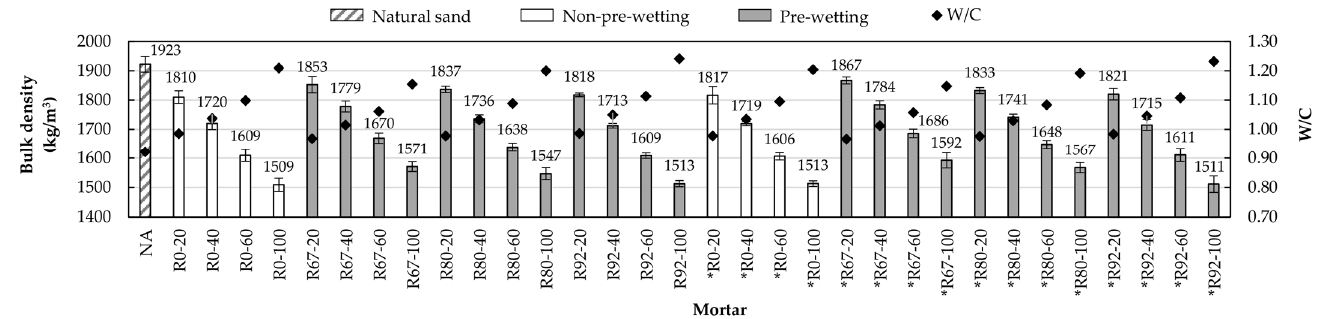
Figure 4. The substitution effect of natural aggregate (NA) by RA in fresh state density.